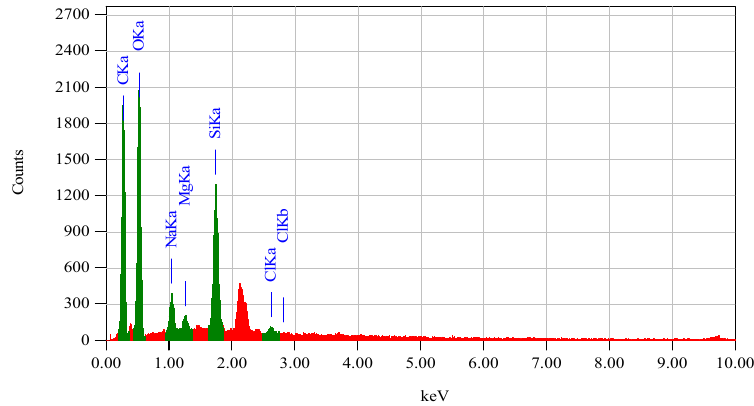
Figure 4. EDS data of the IOCMs containing silica particles from rice husk. Other IOCM characteristics are shown in the FTIR spectra (Figure 5) compared to the those of the silica particles and pure chitosan membrane. It can be seen that the spectrum of the IOCM (a) is a composite spectrum between the spectrum of the silica particles (b) and pure chitosan membrane (c). The functional groups of IOCMs were identified by ab- sorption at a wavenumber of 957 cm − 1 for Si–O stretching vibration and a wavenumber of 1092 for Si–O–Si symmetrical stretching vibration, as well as the –OH silanol group at a wavenumber of 3422 cm − 1 . The chitosan content is attributed to the absorbance at 1634 cm − 1 (–C=O carbonyl group), 1570 cm -1 (bending vibrations of NH groups), 1419 cm -1 (bending vibration of CH group), and 1924 cm − 1 (stretching vibration of aliphatic -CH